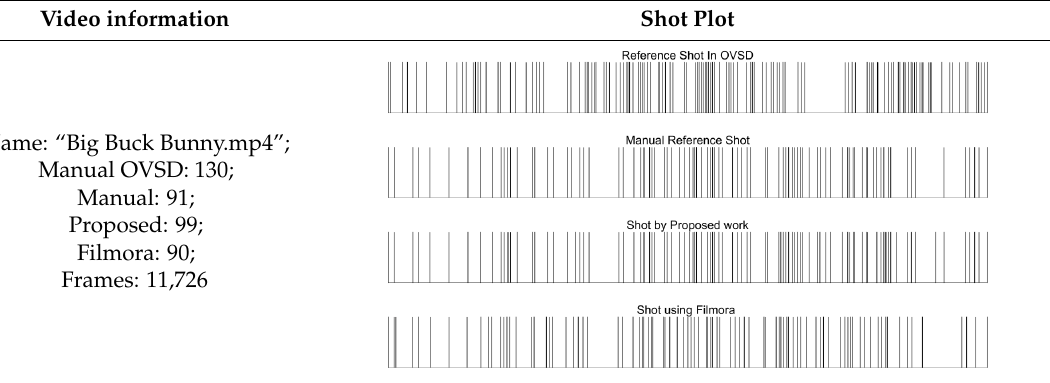
Table 10. The examples of the SBD results.